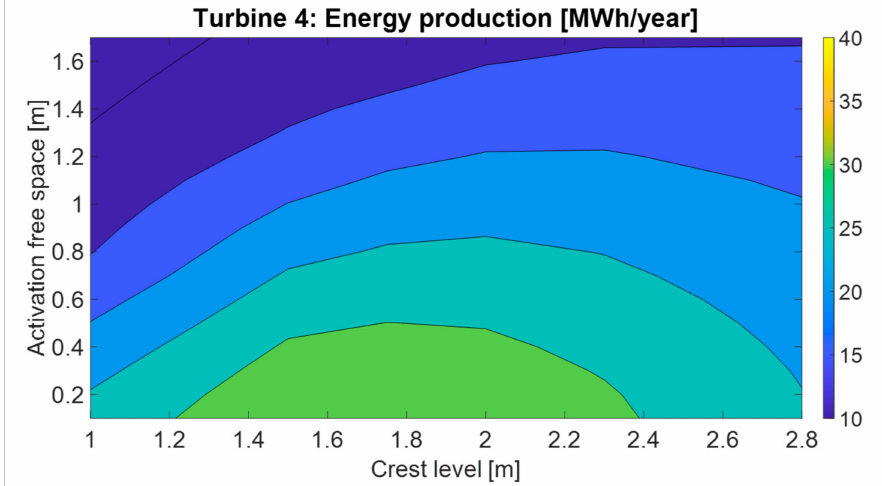
Figure 10. Energy produced by Turbine 4 as a function of the activation free space f a and the crest level h cr